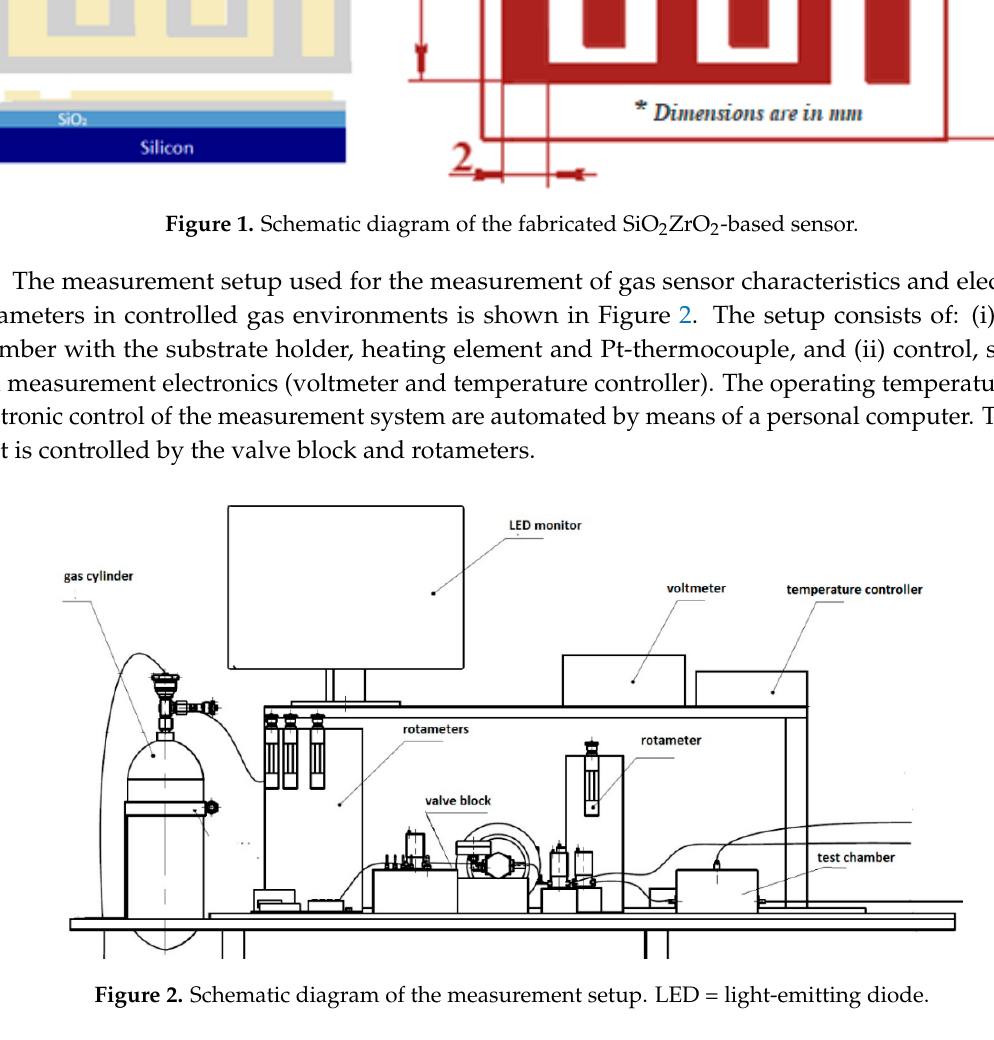
Figure 2. Schematic diagram of the measurement setup. LED = light-emitting diode.